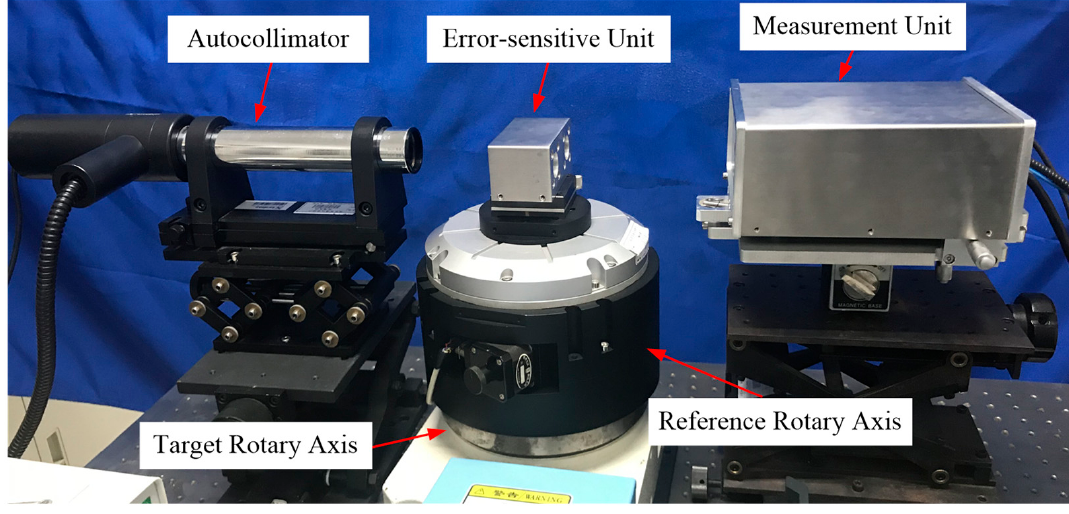
Figure 7. Measurement experiments of rotary axis.